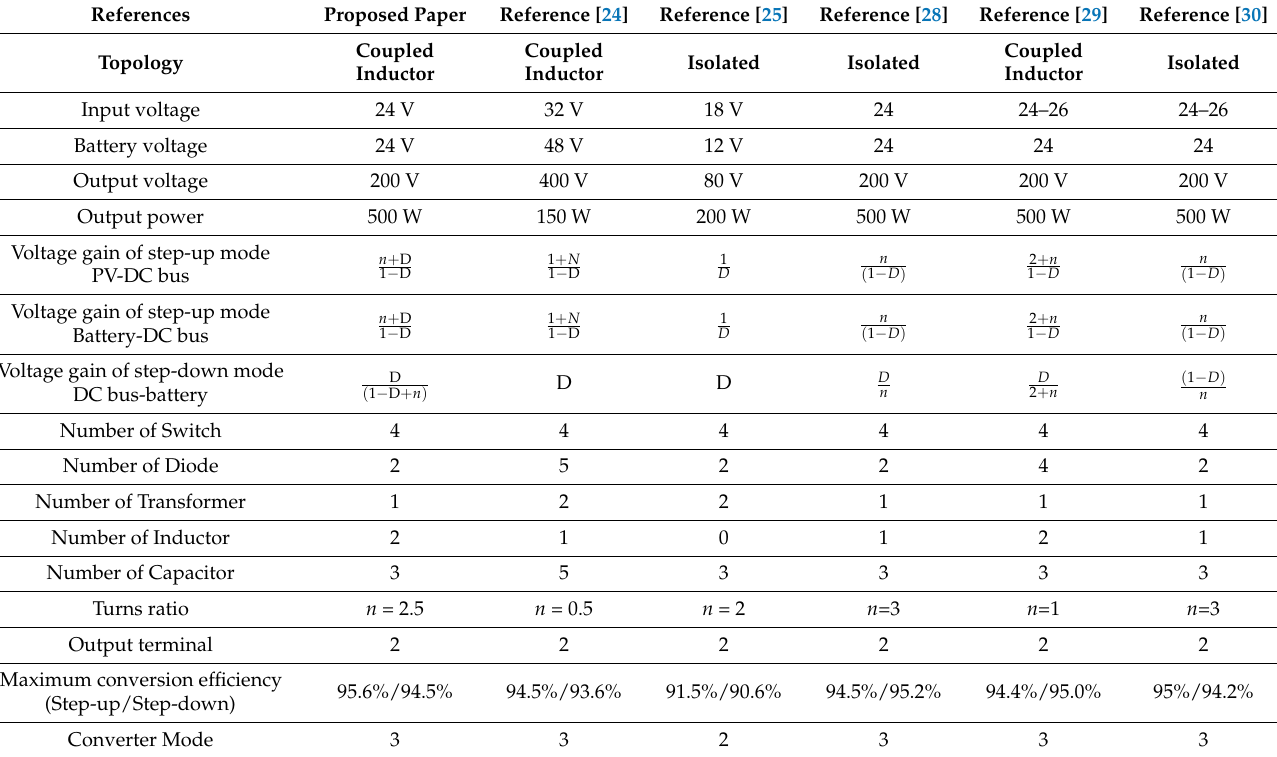
Table 2. Comparison of the proposed converter with other presented three-port